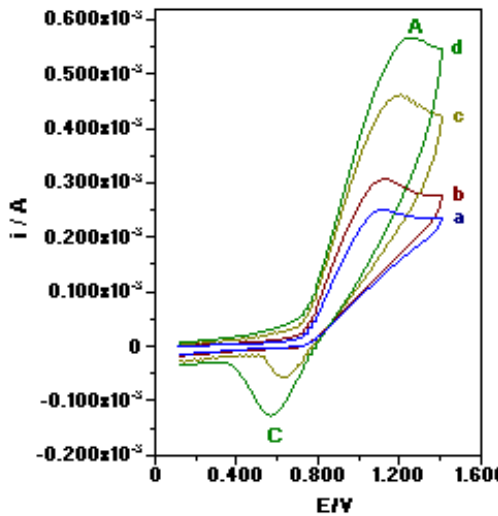
Figure 2. Cyclic voltammograms of 5 × 10 − 3 M NaBr in the presence of 5 × 10 − 3 M 1,3-indan- dione in various potential scan rate at glassy carbon electrode in MeOH/AcOH (3%)(V/V). Scan rate from (a) to (d), is: 50, 100, 300 and 500 mV/s, respectively. . T = 25 ± 1 o C. Supporting electrolyte: 0.10 M KNO 3